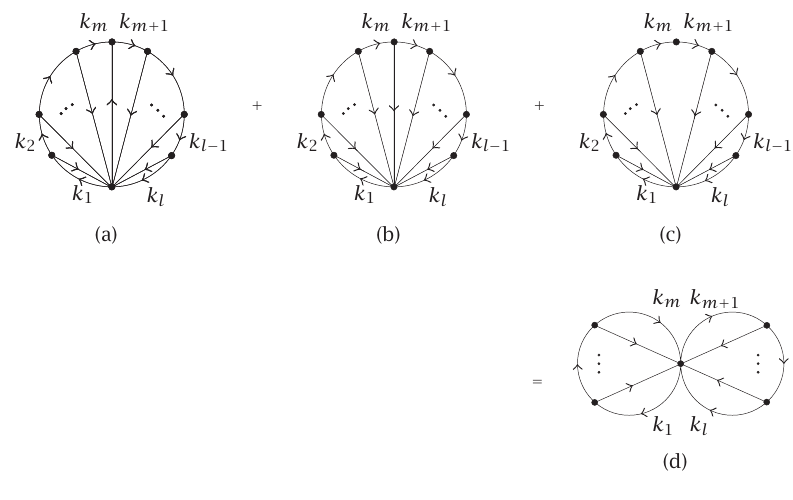
Figure 4.8 . Diagrammatic representation of permutation identities for ar- bitrary length. The propagators without label are g ( 0 )